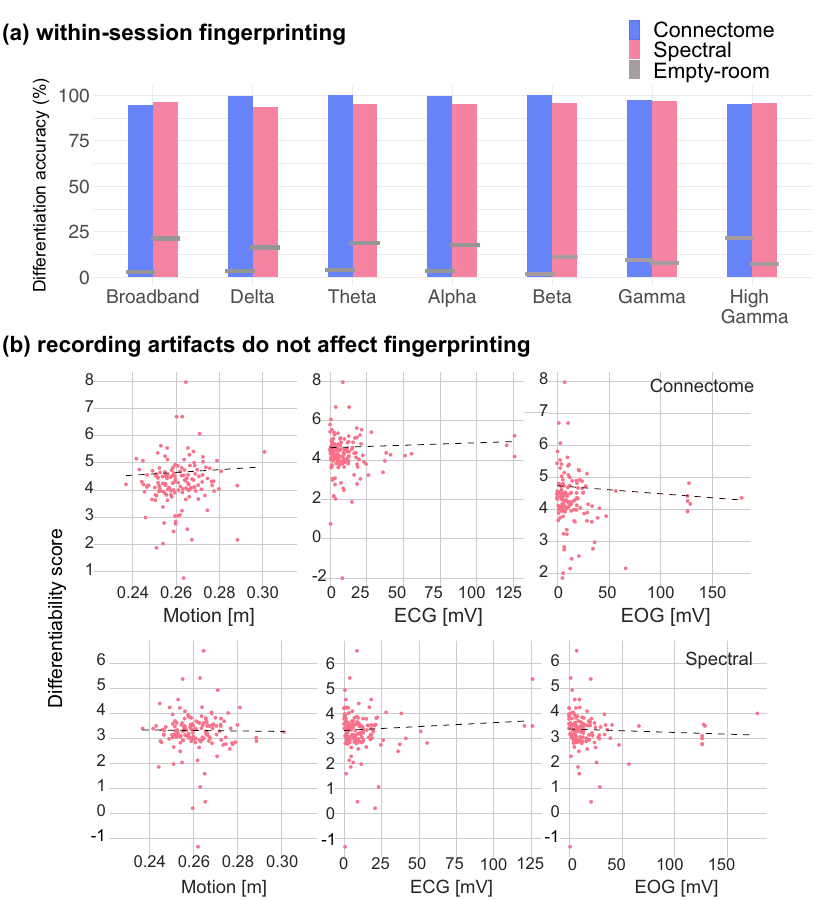
Fig. 2 Within-session differentiation is not related to recording artifacts. a Differentiation accuracy of connectome and spectral fi ngerprinting based on broadband and narrowband brain signals. Horizontal gray bars indicate reference differentiation levels obtained from empty-room data recorded on the same days as participants (see “ Methods ” ). b Differentiability scores were not related to typical confounds such as head motion, eye movements, and heartbeats. Top row: using connectome fi ngerprinting; bottom row: spectral fi ngerprinting. Source data are provided as a Source Data fi